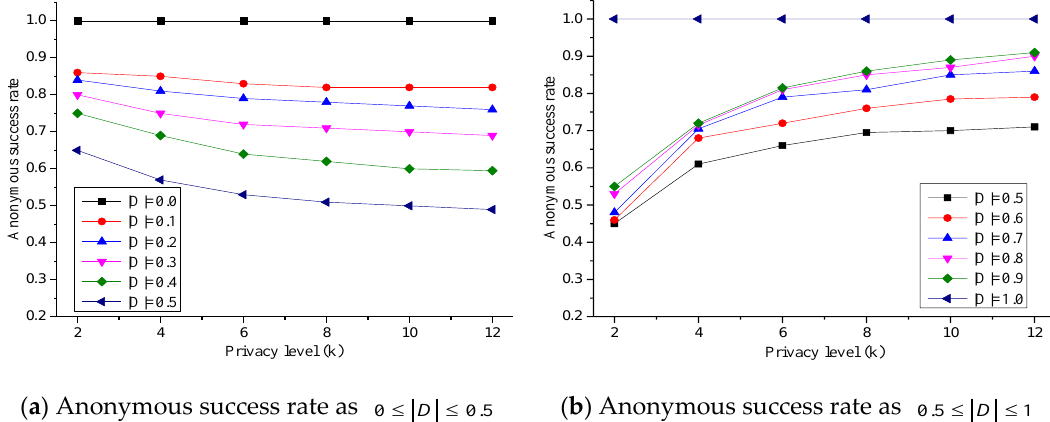
Figure 9. Effect of anonymous success rate in different amount of privacy.